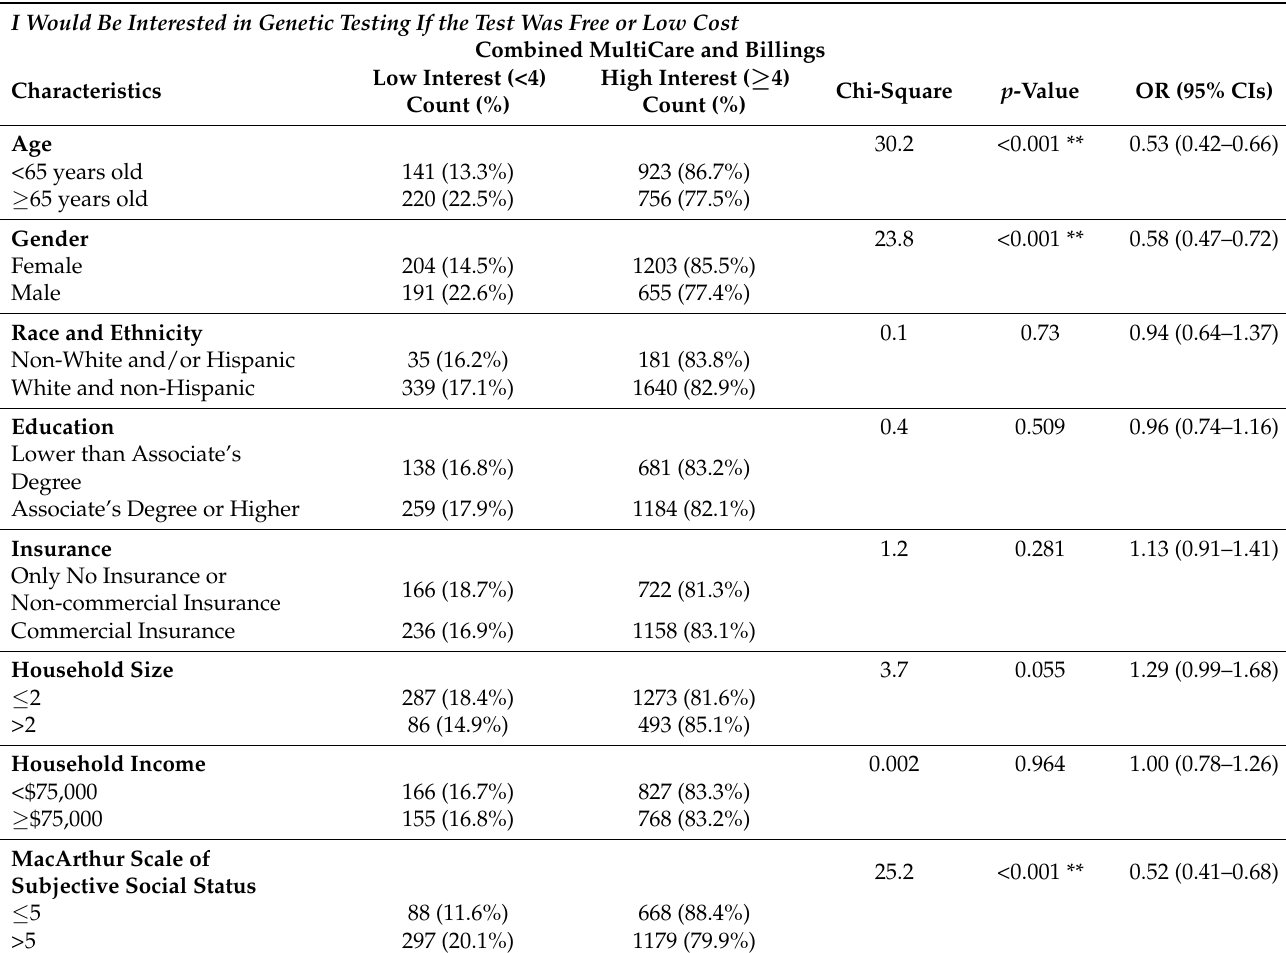
Table 3. Bivariate analysis for interest outcome